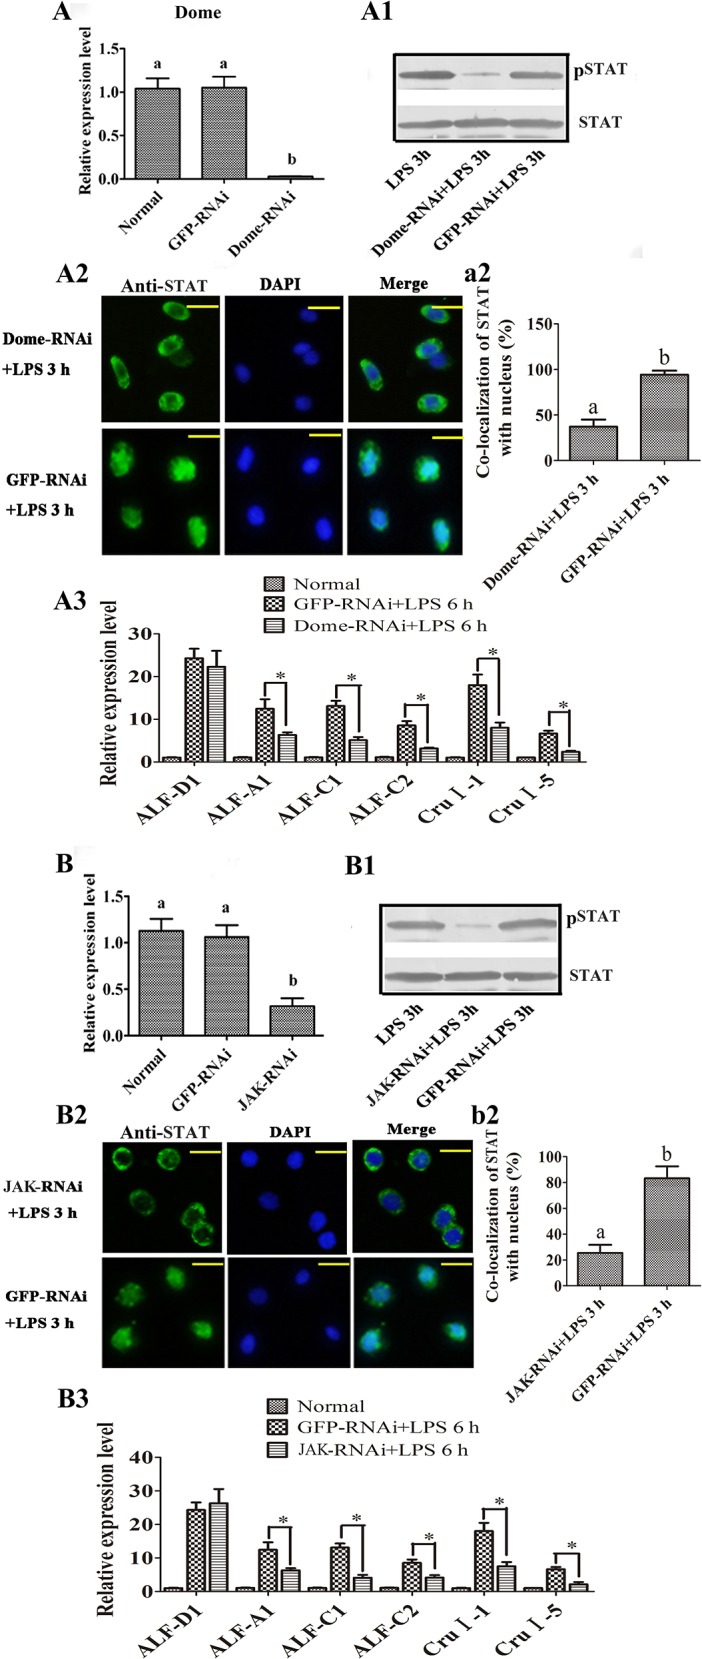
RNAi against Dome or JAK inhibited the phosphorylation and translocation of STAT and impaired the expression of five AMPs.(A) RNAi efficiency against Dome was analyzed by qRT-PCR. (A1) STAT phosphorylation in Dome-silenced shrimp was determined by western blotting. (A2-a2) STAT translocation in the hemocytes of Dome-silenced-shrimp was detected using an immunocytochemical assay with a STAT-specific antibody. a2 is the STATistical analysis of A2: the localization of STAT within the nucleus of hemocytes was analyzed using WCIF ImageJ software. (A3) The expression of ALF-A1, ALF-C1, ALF-C2, ALF-D1, CruI-1 and CruI-5 in Dome-silenced shrimp was analyzed by qRT-PCR. (B) The RNAi efficiency of JAK was analyzed with qRT-PCR. (B1) STAT phosphorylation in JAK-silenced shrimp was determined by western blotting. (B2-b2) STAT translocation in the hemocytes of JAK-silenced shrimp was determined using an immunocytochemical assay with a STAT-specific antibody. b2 is the Statistical analysis of B2: the localization of STAT within the nucleus was analyzed using WCIF ImageJ software. (B3) The expression of ALF-A1, ALF-C1, ALF-C2, ALF-D1, CruI-1 and CruI-5 in JAK-silenced shrimp was analyzed with qRT-PCR. Different letters indicate significant differences (p < 0.05) in a one-way ANOVA analysis. Differences in AMP expression were analyzed using a t-test (*p < 0.05).